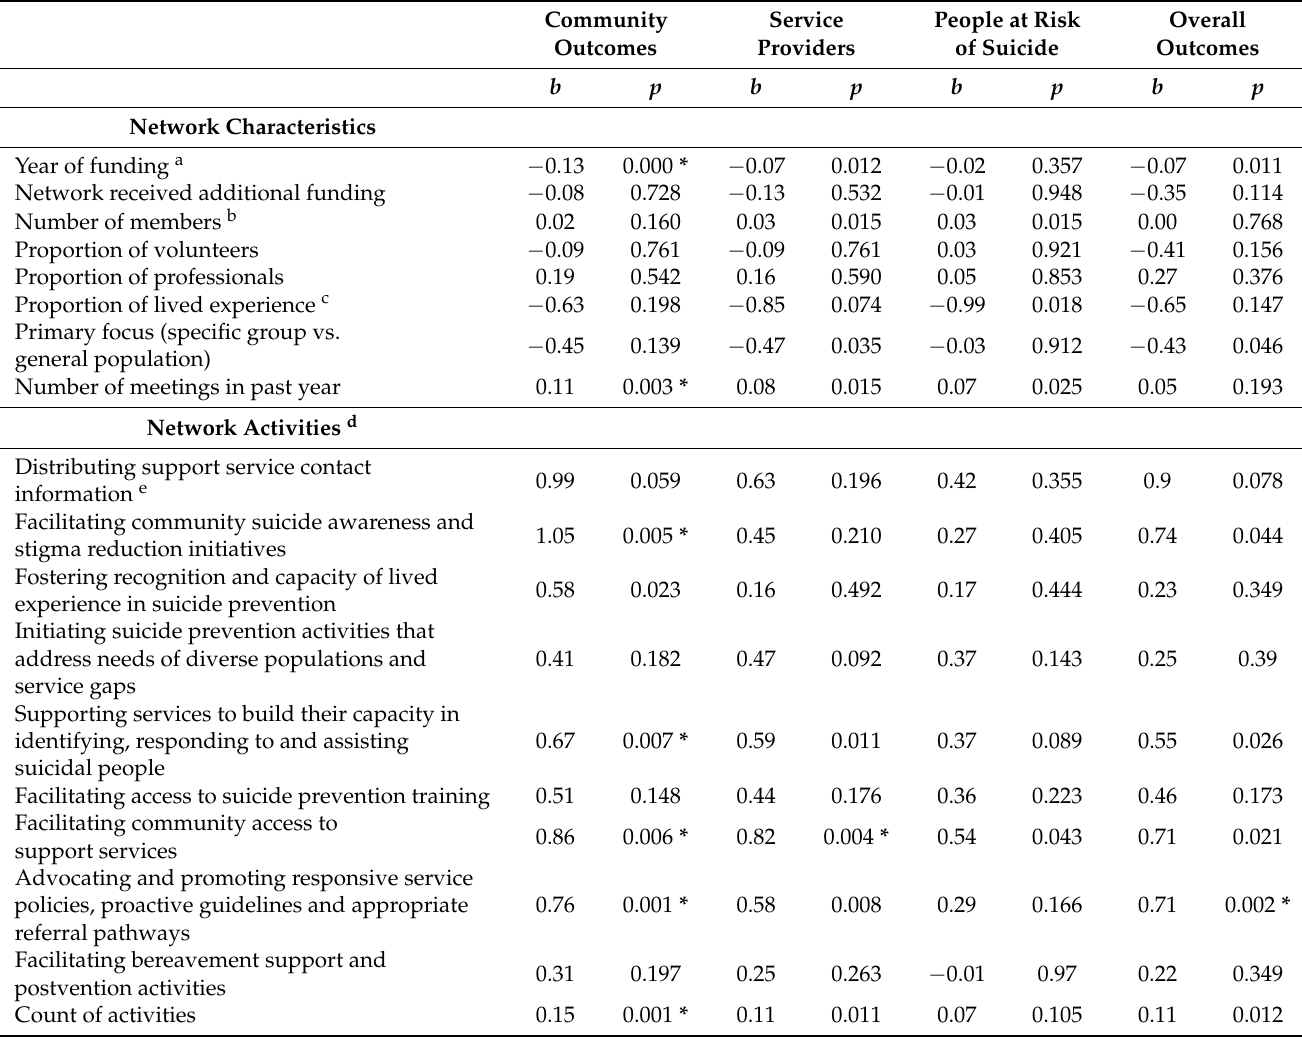
Table 6. Predictors of perceived community outcomes (univariate linear regressions).